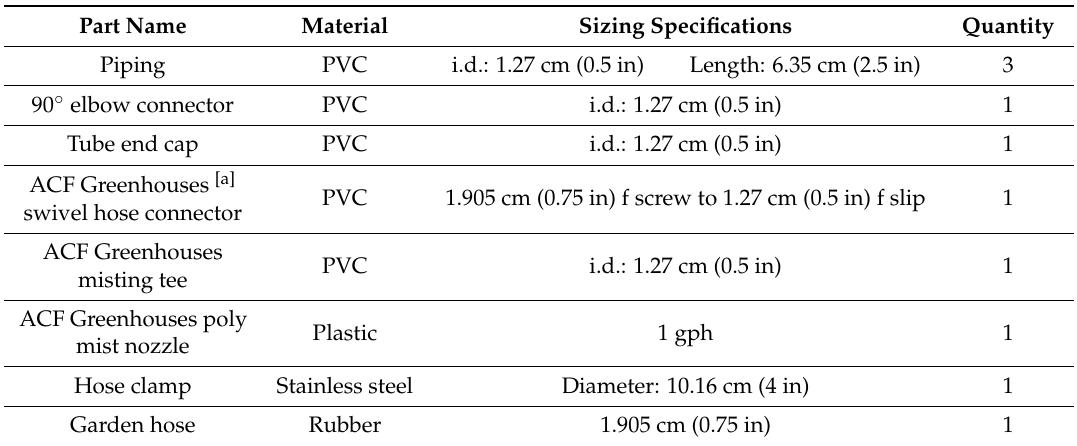
Table 3. The following is a complete parts list for the soil column mist nozzle and piping portion of the complete soil column system, as shown in Figure